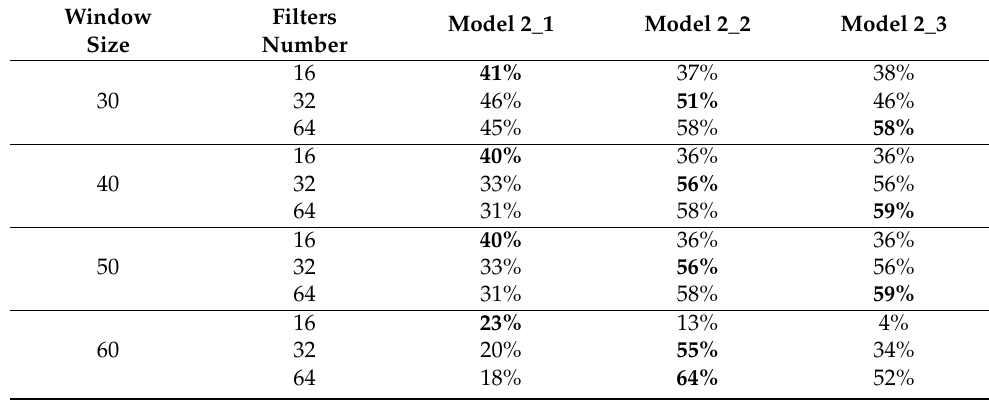
Table 4. The accuracy for models in Experiment 2 using different window sizes and filter numbers.